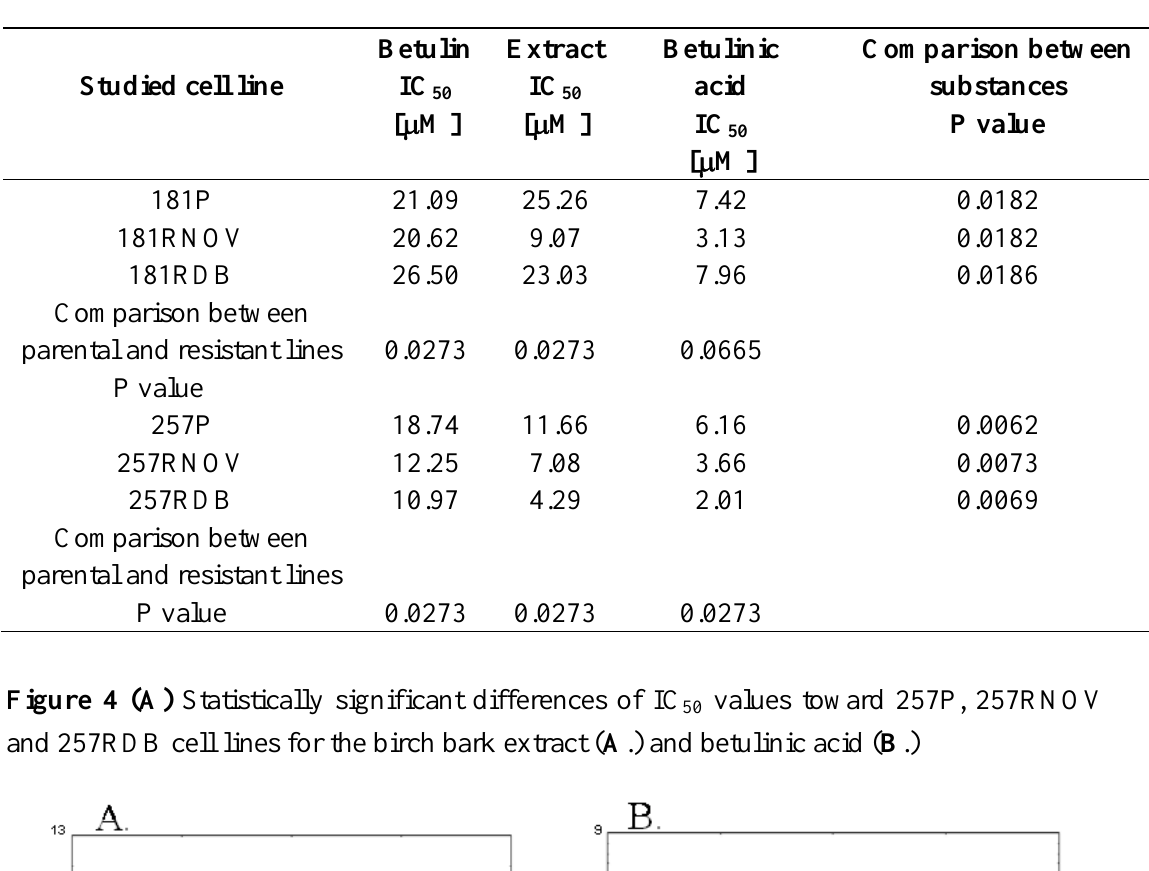
Table 1. IC values of the tested compounds towards parental lines and their drug-resistant 50 sublines. Results obtained using the ANOVA rank test of Kruskal-Wallis. Comparison between the substances and their IC towards parental lines and their drug resistant 50